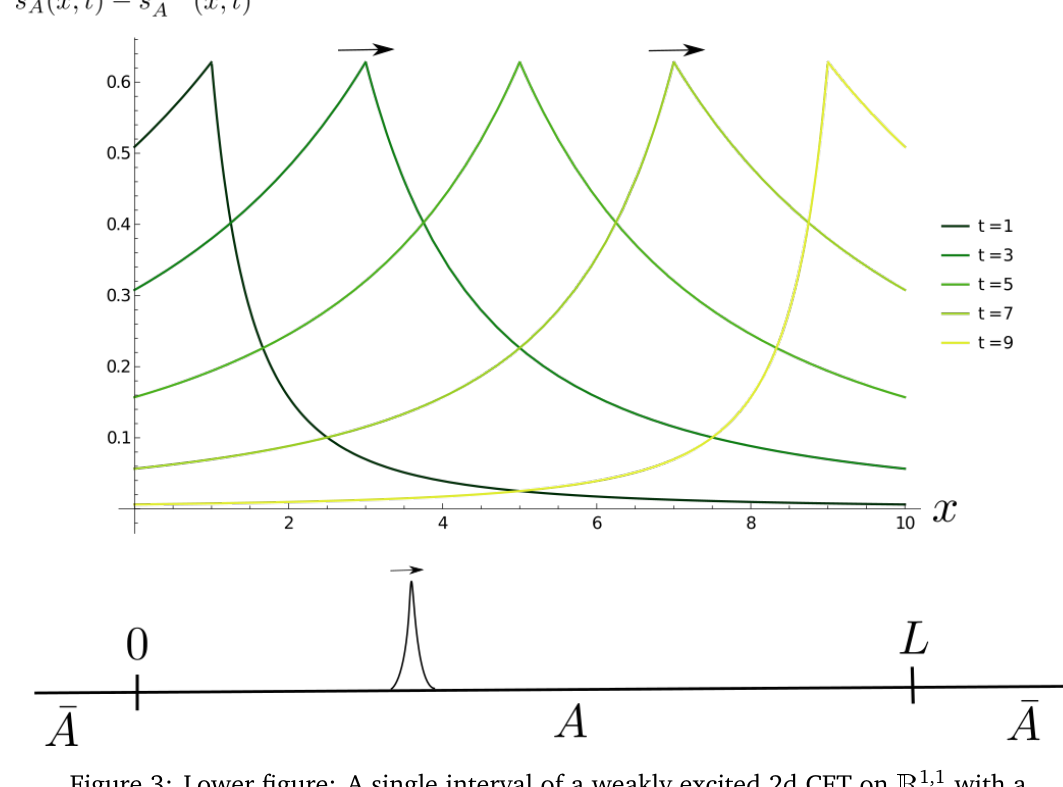
Figure 3: Lower figure: A single interval of a weakly excited 2d CFT on R 1,1 with a localised low-energy pulse. Upper figure: Vacuum-subtracted entanglement contour of that interval, given by equation (35), and plotted with E = 1 / 10 and L = 10. The peak of the entanglement contour wave is centred on and travels with the energy